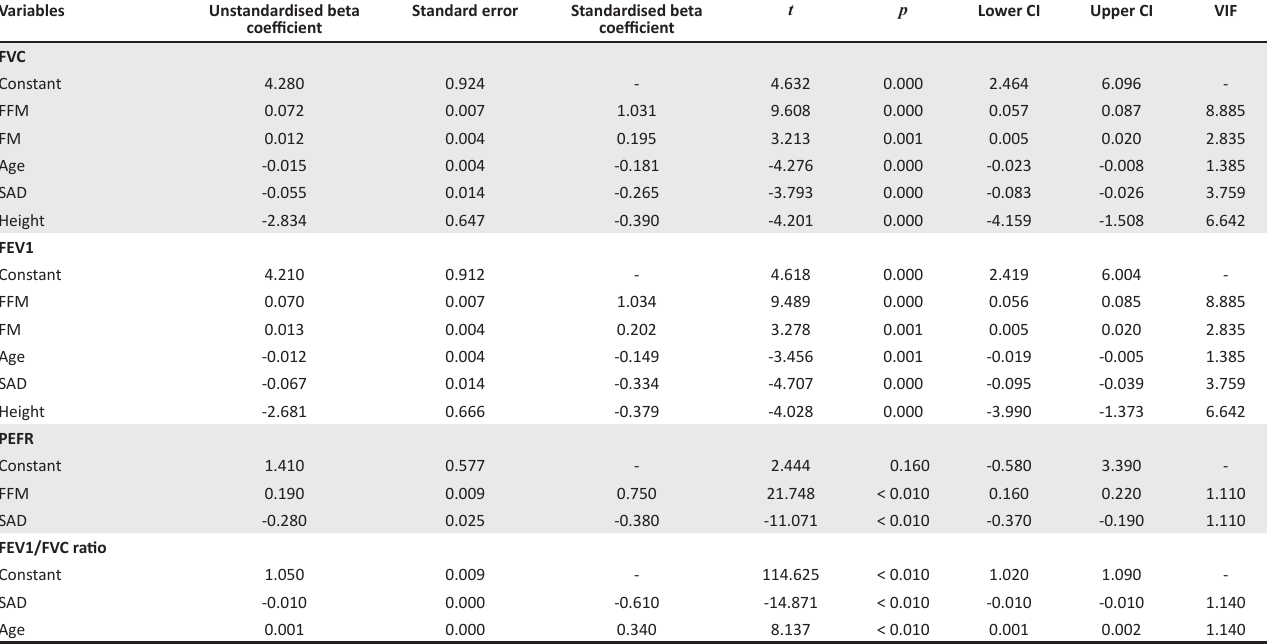
TABLE 4: Predictors of lung function parameters ( n = 444).